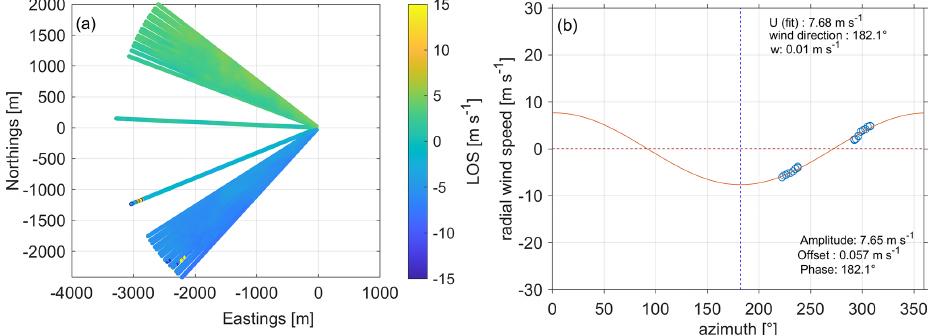
Figure 4. (a) Example of the top view of the radial wind speed ( u r ) for a single full scan taking approximately 75s on 29 August 2020. Eastings and northings are given in meters and relative to the lidar position. (b) Example of VAD data selected from the scan in (a) for a distance of 1500m ± 150m and a height of 120m ± 5m. The bottom legend shows results for the radial wind speed fit. The top legend indicates results of the wind speed.